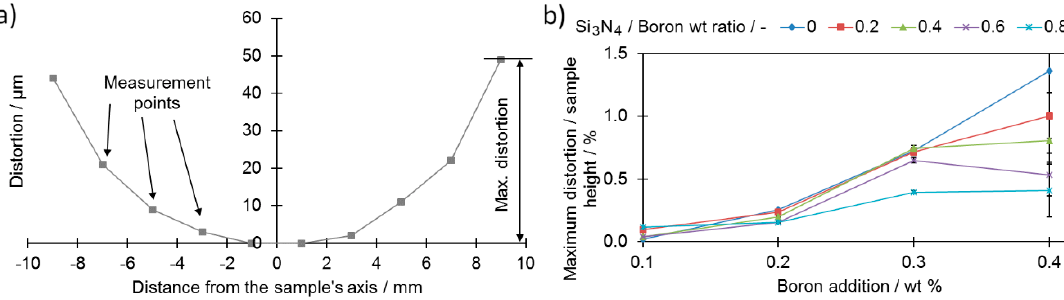
Figure 10. Density change of prismatic samples in the boron and silicon nitride addition functions. Numerical data are available in Table S5 in the Supplementary Material. This results from the lower compatibility of prismatic samples due to the presence of corners and relatively large outline surfaces compared to the cross-section. Both of these features impede the compaction process and, therefore, decrease the green density. The average green density of the